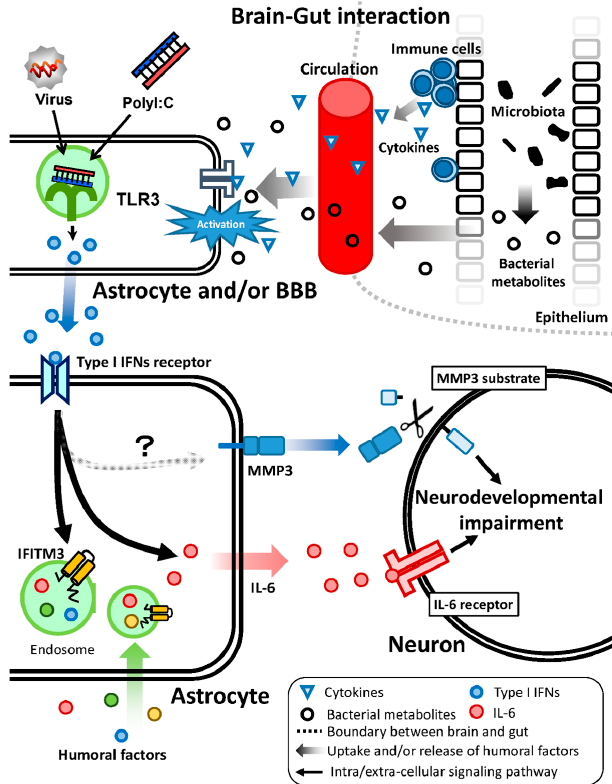
Figure 1. This schematic presents the model for neurodevelopmental disturbances by polyI:C treatment. PolyI:C induces type I IFNs expression in astrocytes and/or the BBB; subsequently,